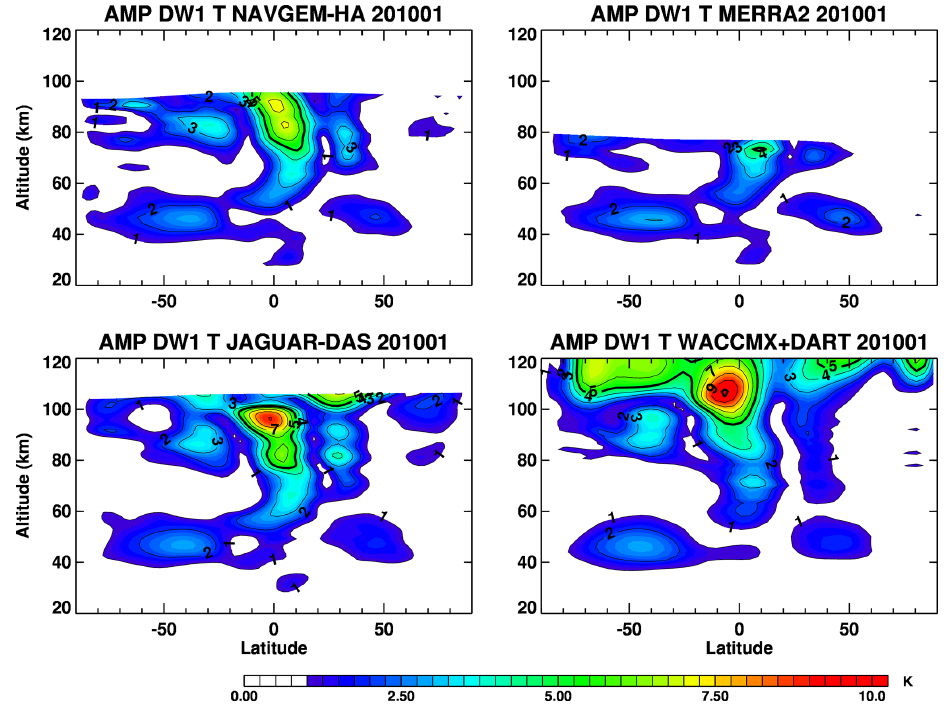
Figure 15. Monthly mean amplitude of the migrating diurnal tide (DW1) in temperature for January 2010 from NAVGEM-HA, MERRA2, JAGUAR-DAS, and WACCMX +